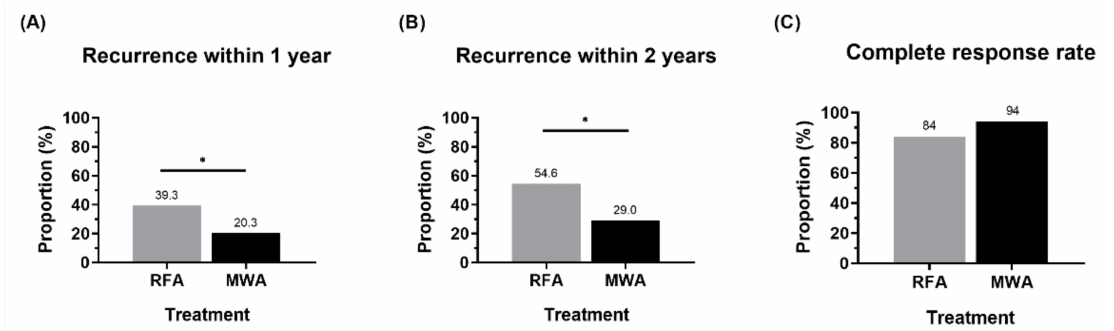
Figure 2. Comparison of recurrent rate ( A , B ) and treatment response ( C ) between RFA and MWA. RFA, radiofrequency ablation; MWA, microwave ablation (* p <